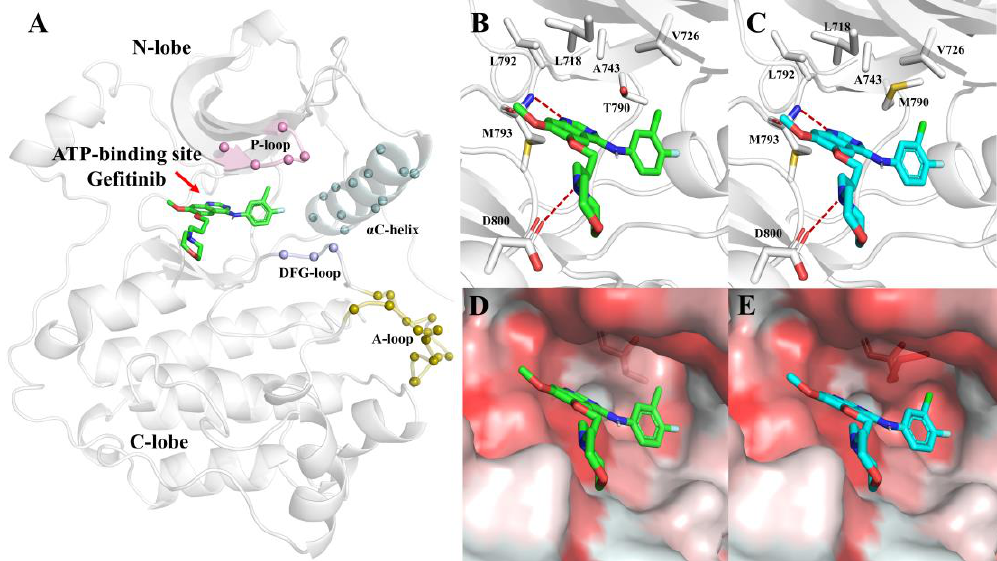
Figure 3. ( A ) The overview structure of the EGFR kinase domain with Gefitinib. P-loop, DFG-loop, A-loop, and regulatory α C-helix are represented by pink, light blue, olive, and pale cyan, respectively. Gefitinib is located in the binding pocket in the G-SM model ( B ) and G-DM model ( C ). Gefitinib displays with green and cyan sticks, respectively. Hydrogen bonds are labeled by red dashed lines. Residues located in the pocket are represented by white sticks. The binding pocket with Gefitinib is shown in the G-SM model ( D ) and G-DM model ( E ), respectively. Hydrophilic surfaces are colored white. Hydrophobic surfaces are colored red.